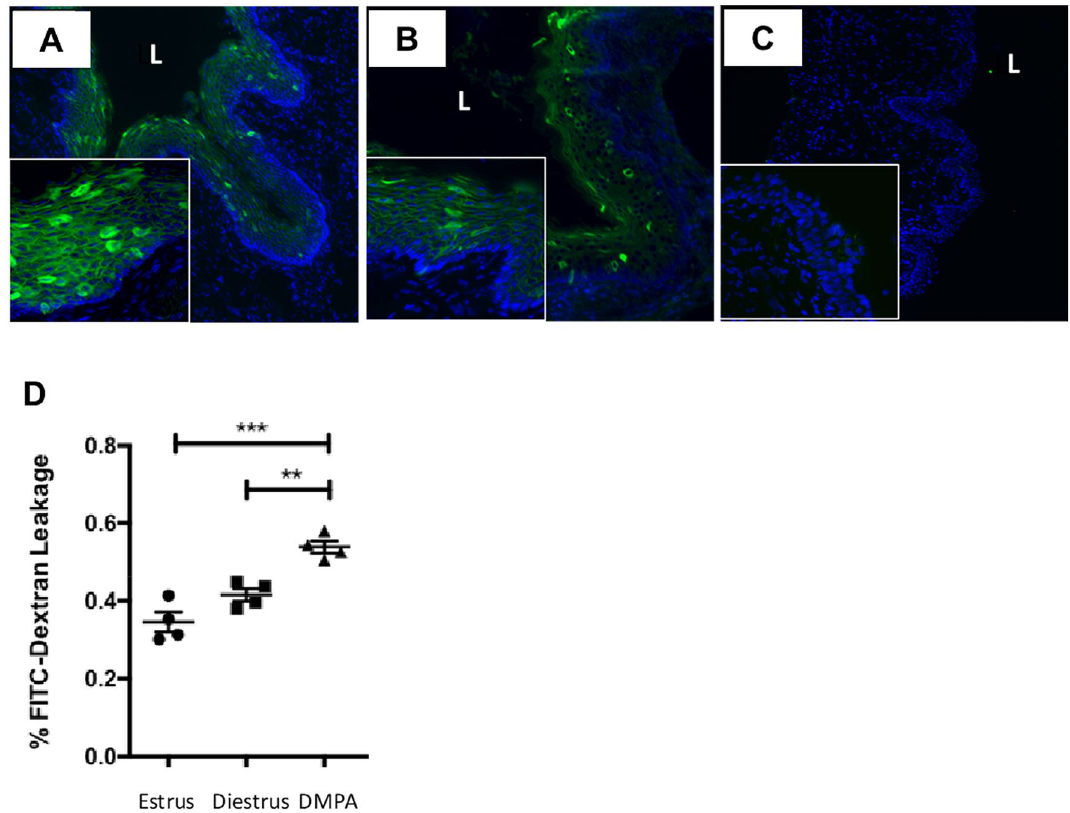
Figure 1. DMPA impairs integrity of the murine vaginal epithelial barrier. C57BL/6 mice were sacrificed at estrus (N = 4) ( A ), diestrus (N = 4) ( B ), or 1 week following a subcutaneous injection of 2 mg of DMPA (N = 4) ( C ). Vaginal tissues were stained by immunofluorescence for the cell–cell adhesion molecule desmoglein-1 (green), and counterstained with DAPI (blue). Mice treated with DMPA appeared to have less desmoglein-1α staining as compared to those in estrus or diestrus. ( D ) We also assessed the murine vaginal barrier in a separate cohort of mice (N = 4/group) by administering a 4 kDa fluorescein isothiocyanate-dextran (FITC-dextran) dye into the vaginal lumen and measuring the fluorescence within the peripheral circulation at sacrifice. Significantly more FITC-dextran dye was quantified in the serum of mice that had received DMPA than those sacrificed during estrus or diestrus. (One-way ANOVA). Taken together DMPA negatively impacts vaginal cell- adhesion molecules, and enhances leakage from the vaginal lumen into the submucosa, ultimately impairing the integrity of the murine vaginal epithelial barrier. ** P ≤ 0.01. *** P ≤ 0.001. Magnifications: 100× and inset is 400×. Data in D is presented as mean ± SEM. DMPA Depot-medroxyprogesterone acetate, L vaginal